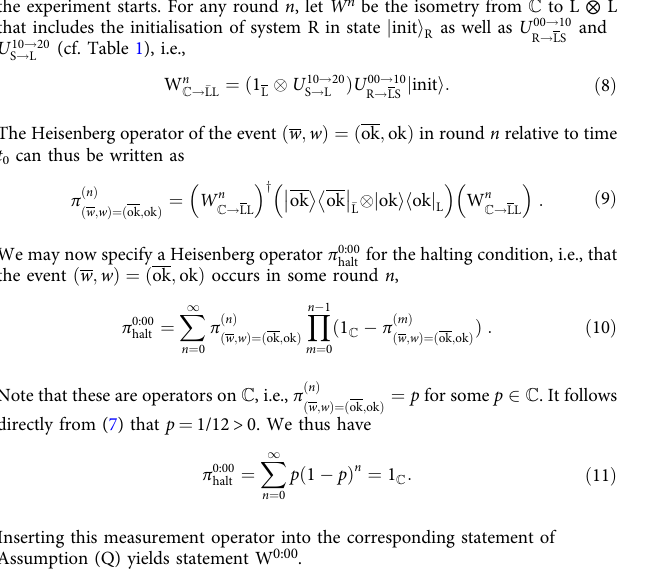
Table 2 Measurements carried out by the agents Agent Value Measured Measurement Relevant vectors of measurement system completed at basis